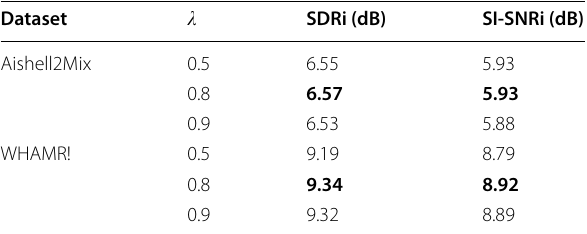
Table 8 Performance of heterogeneous separation results fusion on Aishell2Mix and WHAMR! test sets Dataset